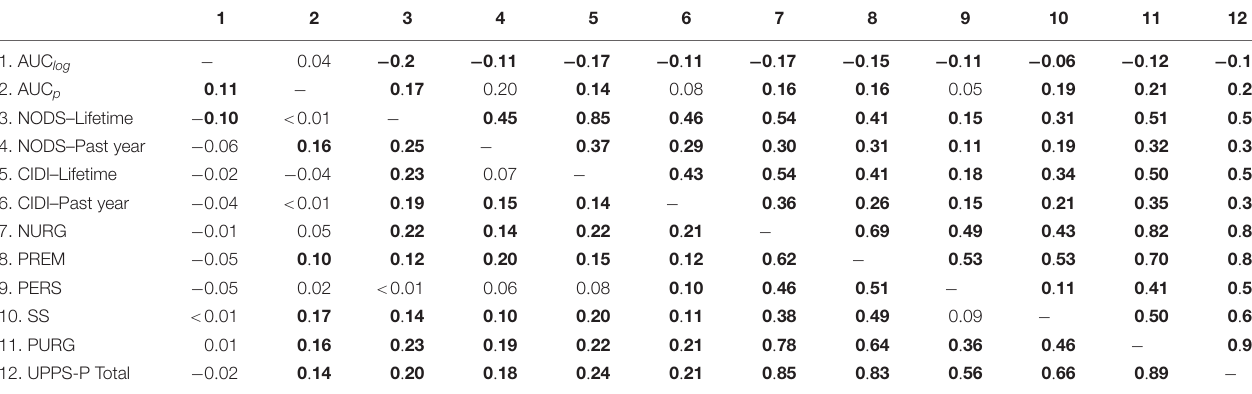
TABLE 2 | Correlations between diagnostic symptom severity, trait impulsivity, measures of gambling activity, delay discounting, and probabilistic discounting.